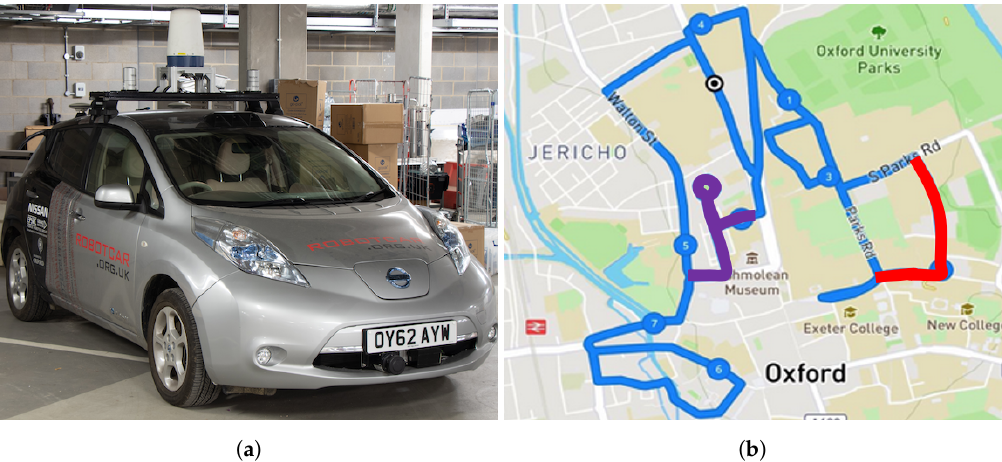
Figure 13. ( a ) The autonomous-capable Nissan Leaf data collection platform as equipped in Section 5.1 for the dataset described in Section 5.2 and ( b ) the 10km route driven in the Oxford Radar Robotcar Dataset . The route is partitioned into training, validation and test data. These are coloured as blue, red, and purple